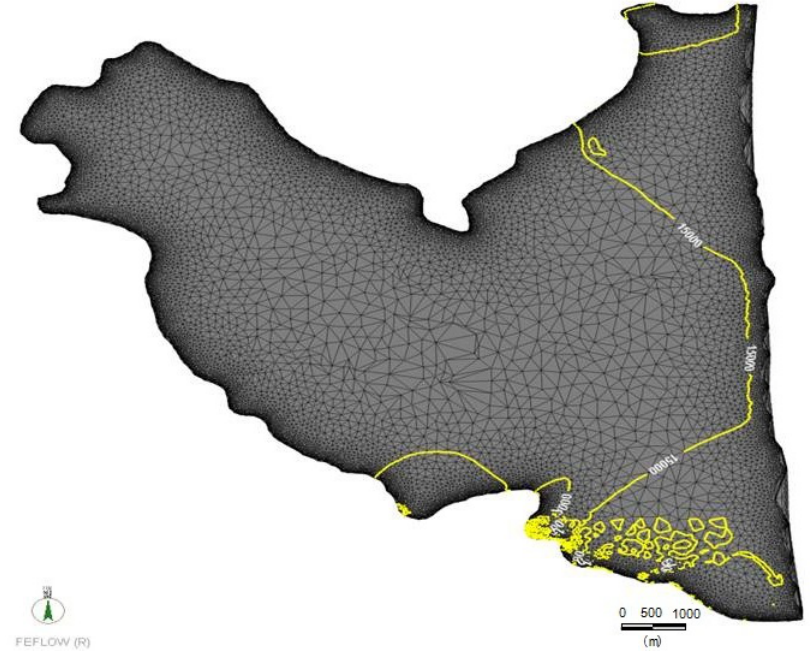
Figure 14. Location of 15,000 mgl − 1 isosalinity contour at 4018 days after pumping rate of 800 m 3 d − 1 per well.